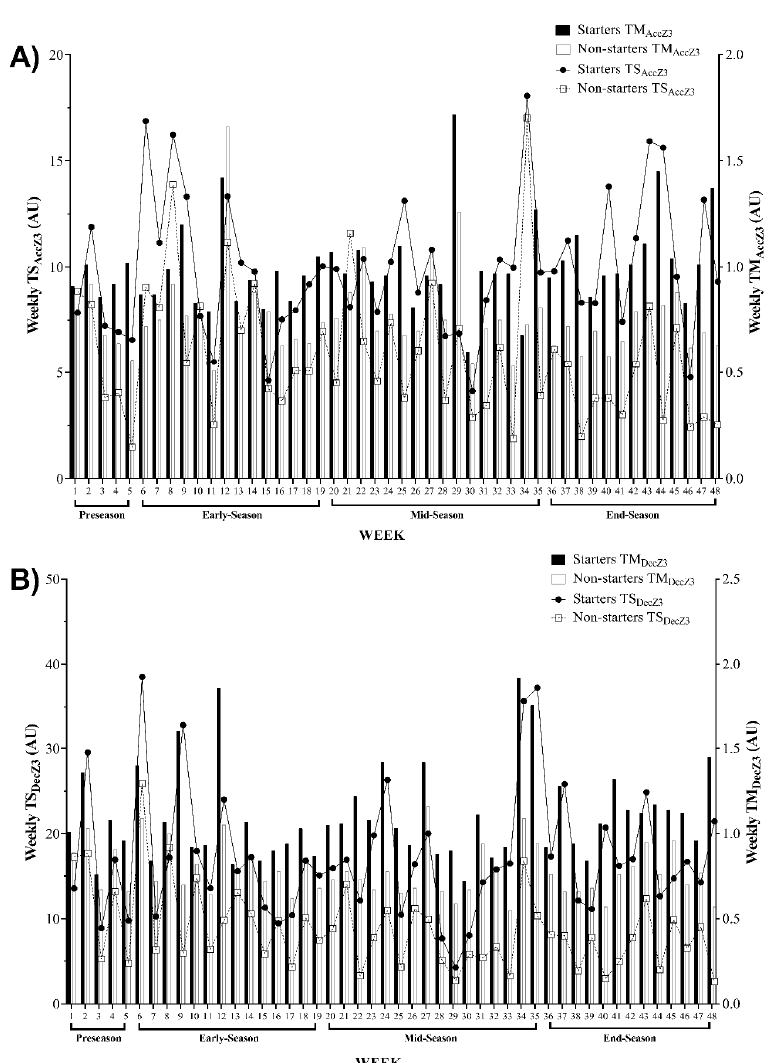
Figure 3. Descriptive statistics of weekly average for training monotony (TM) and training strain (TS) and their variations across the full season based on ( A ) number of accelerations in zone 3 ( > 4 m · s − 2 ) and ( B ) number of decelerations in zone 3 ( < − 4 m · s − 2 ). AU, arbitrary units; TM AccZ3 , weekly training monotony based on number of accelerations in zone 3 ( > 4 m · s − 2 ); TS AccZ3 , weekly training strain based on number of accelerations in zone 3 ( > 4 m · s − 2 ); TM DecZ3 , weekly training monotony based on number of decelerations in zone 3 ( < − 4 m · s − 2 ); TS DecZ3 , weekly training strain based on number of decelerations in zone 3 ( < − 4 m · s − 2 ).